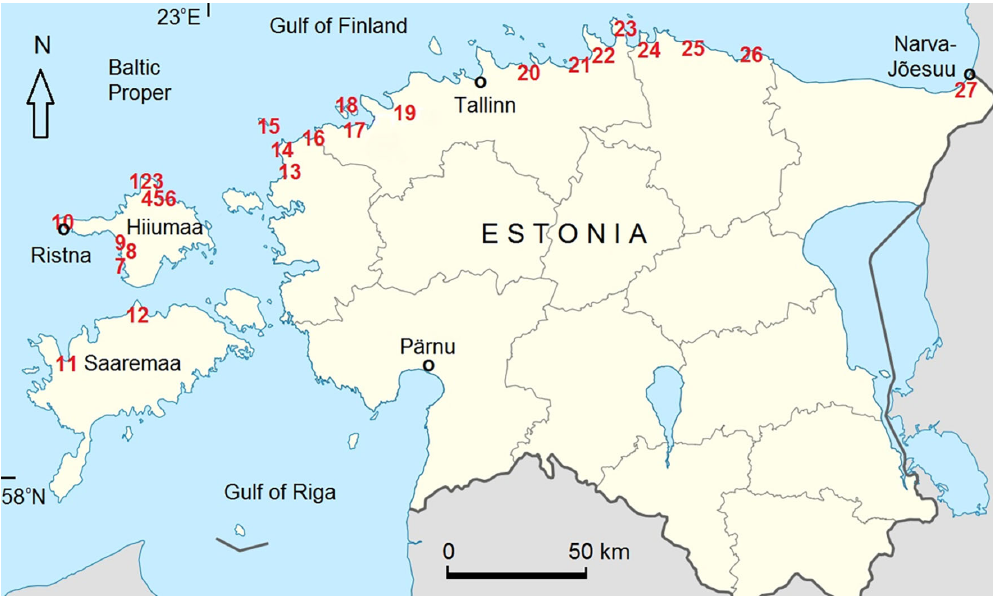
Fig. 1. Map of Estonia with enumerated beach ridge systems (see Table 1) and tide gauge